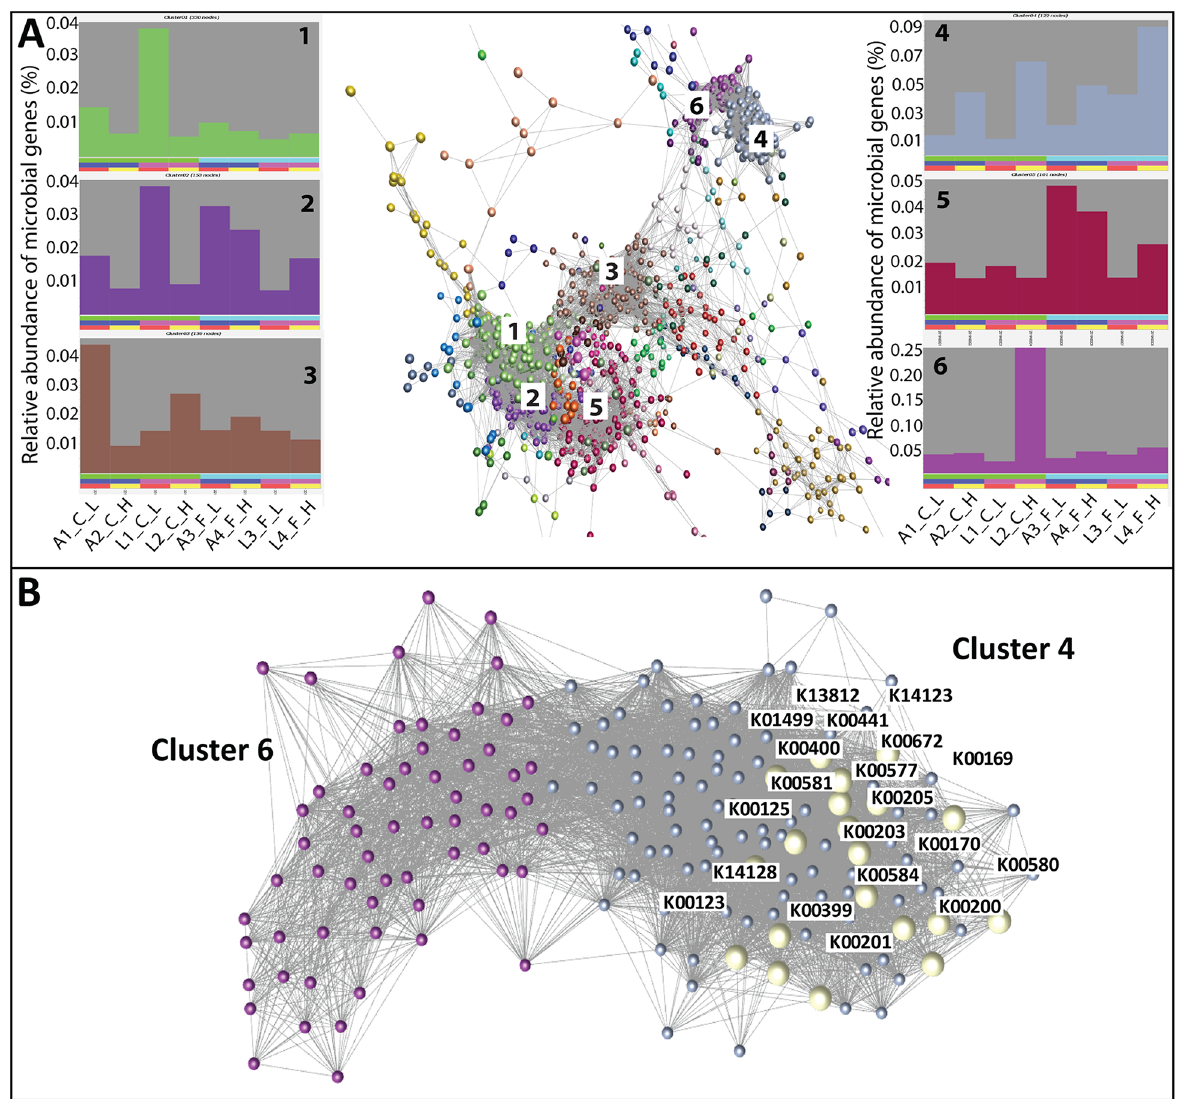
Fig 3. Functional clusters of microbial genes identified using network analysis. (A) Correlation analysis of microbial gene abundance was used to construct networks, where nodes represent microbial genes and edges the correlation in their abundance. Networks were clustered using the MCL algorithm and the profiles of clusters 1 to 6 are shown. Each chart represents the average abundance of genes in a cluster across the animals studied. Animals are ordered alternately being low (red bar beneath plot) and high methane emitter (yellow), whereby the first and last 4 bars represent animals offered concentrate (green) and forage (light blue) diets, respectively. See S2 Table for KEGG genes associated within each cluster. (B) Microbial gene networks of cluster 4 and 6 contained most of the microbial genes associated with methane metabolism; explicitly shown in yellow are the KEGG genes identified by the PLS analysis to be most closely associated with methane emissions (see Fig 4 and S3